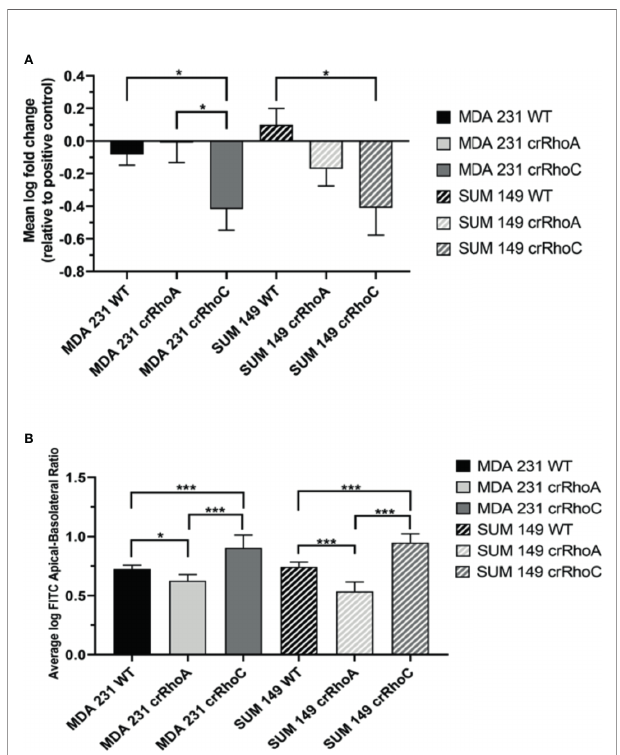
FIGURE 3 | Rho expression changes cell-cell adhesiveness and junction stability. (A) Quanti fi cation of difference in fl uorescent intensity between positive control (non-adhering) and test wells in centrifugation adhesion assay (n = 3 biological replicates); decreases in fl uorescent intensity correspond to increases in cell-cell adhesiveness. crRhoC cells have signi fi cantly increased adhesiveness compared to wild type. (B) Quanti fi cation of the ratio of fl uorescent intensity in apical vs basal chambers in FITC-Dextran barrier permeability assay (n = 3 biological replicates); higher ratio corresponds to increased barrier integrity. crRhoA cells have decreased barrier integrity compared to wild-type, whereas crRhoC cells have increased barrier integrity. Solid bars are MDA 231, striped bars are SUM 149; black bars are wild-type, light grey bars are crRhoA, and dark grey bars are crRhoC cells. *p < 0.05; ***p <